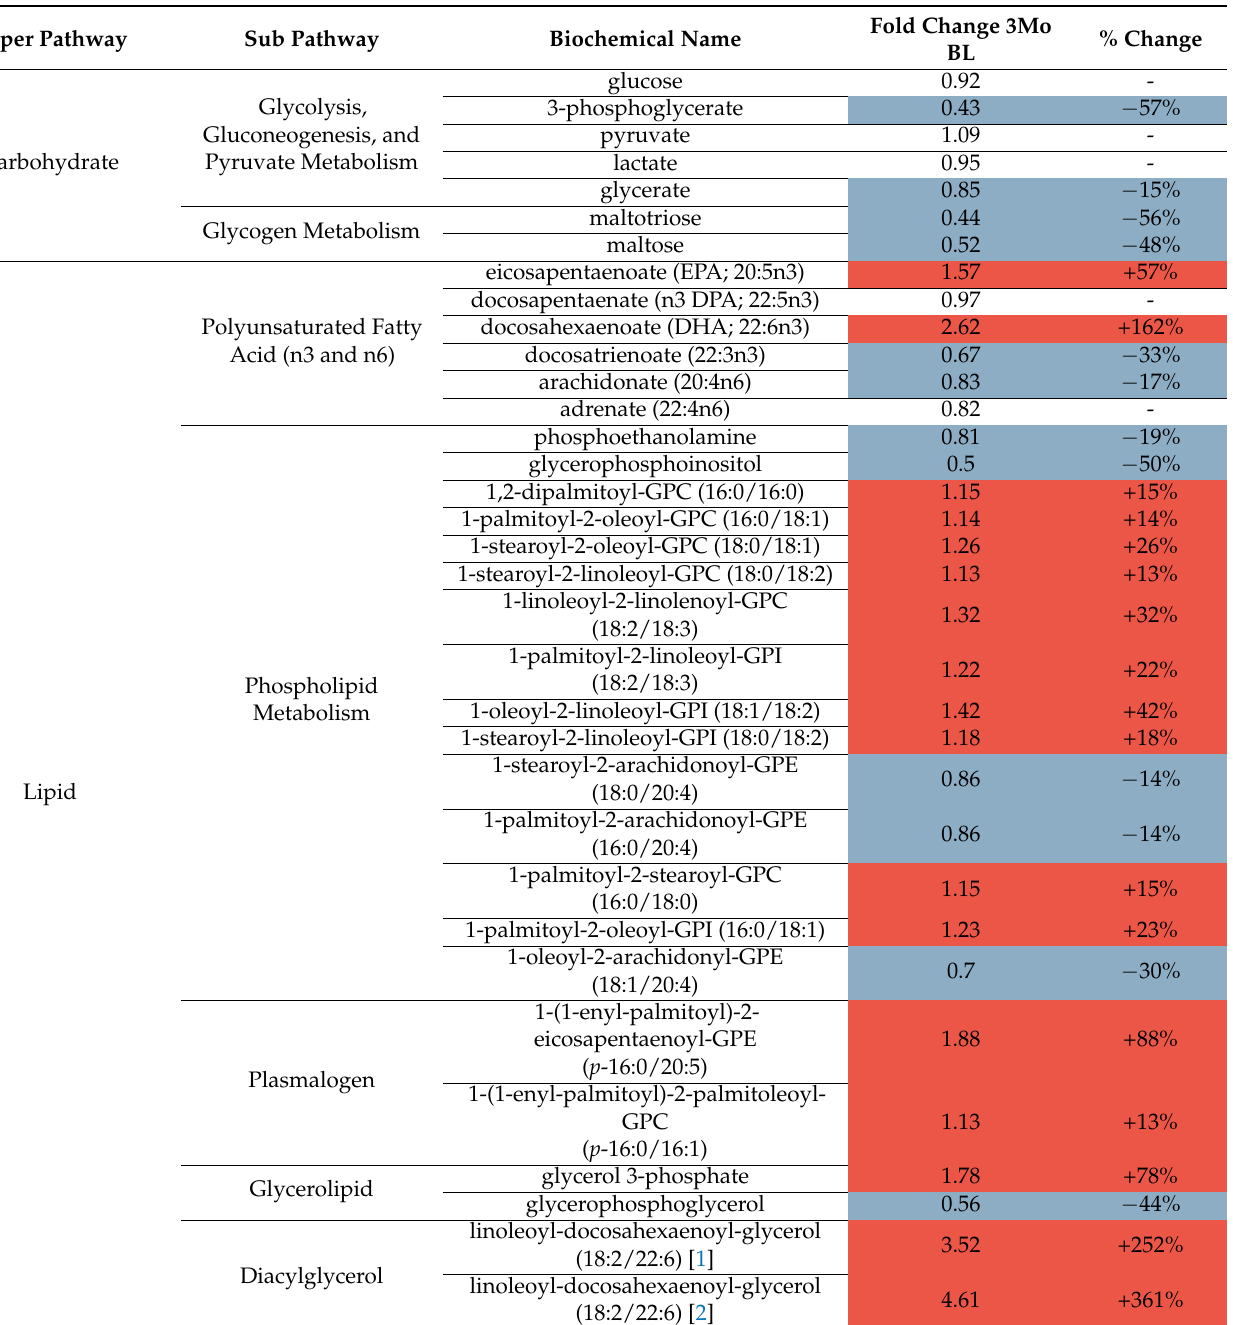
Table 5. Metabolites of glucose and glycerolipid